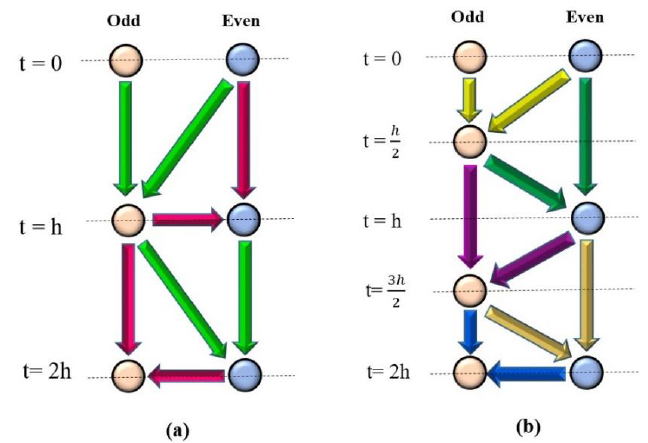
Figure 1. The stencil of the odd-even hopscotch structures for two nodes. ( a ) The original OEH algorithm. Green arrows represent first-stage operations and data usage while red arrows are for the second stage. ( b ) The new, shifted OEH algorithm. Yellow, green, purple, brown, and blue arrows indicate operations at Stages 1, 2, 3, 4 and 5,